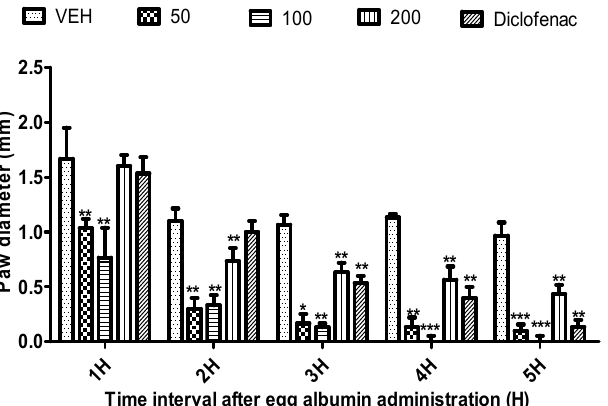
Figure 2. Effect of “White Marsh” grapefruit ( C. paradisi ) fresh leaf essential oil on egg albumin- induced rat paw oedema. Results are expressed as Mean ± SEM. VEH, ECH and ASA represent vehicle (5% Tween 80), Marsh leaves essential oil (FMLG) and diclofenac, respectively. * p < 0.05, ** p < 0.01 and *** p < 0.001, statistically different from negative control group (ANOVA, Dunnett’s).